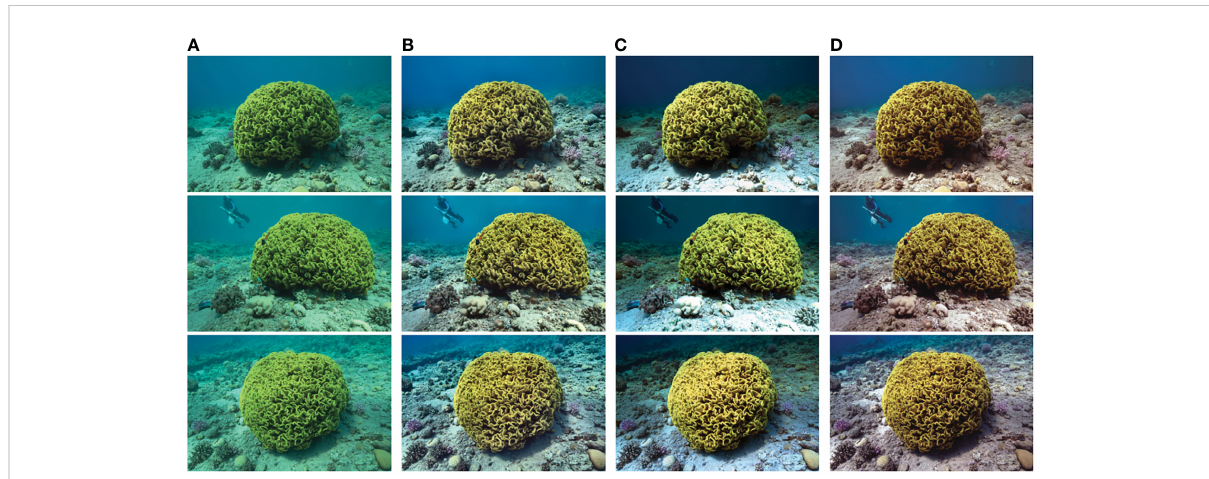
FIGURE 10 Visual comparisons on the 7968×5312 images in the D3 dataset. From left to right, (A) shows the raw underwater images, (B – D) are the results of Fusion (Ancuti et al., 2012), Sea-thru (Akkaynak and Treibitz, 2019) and the proposed model,